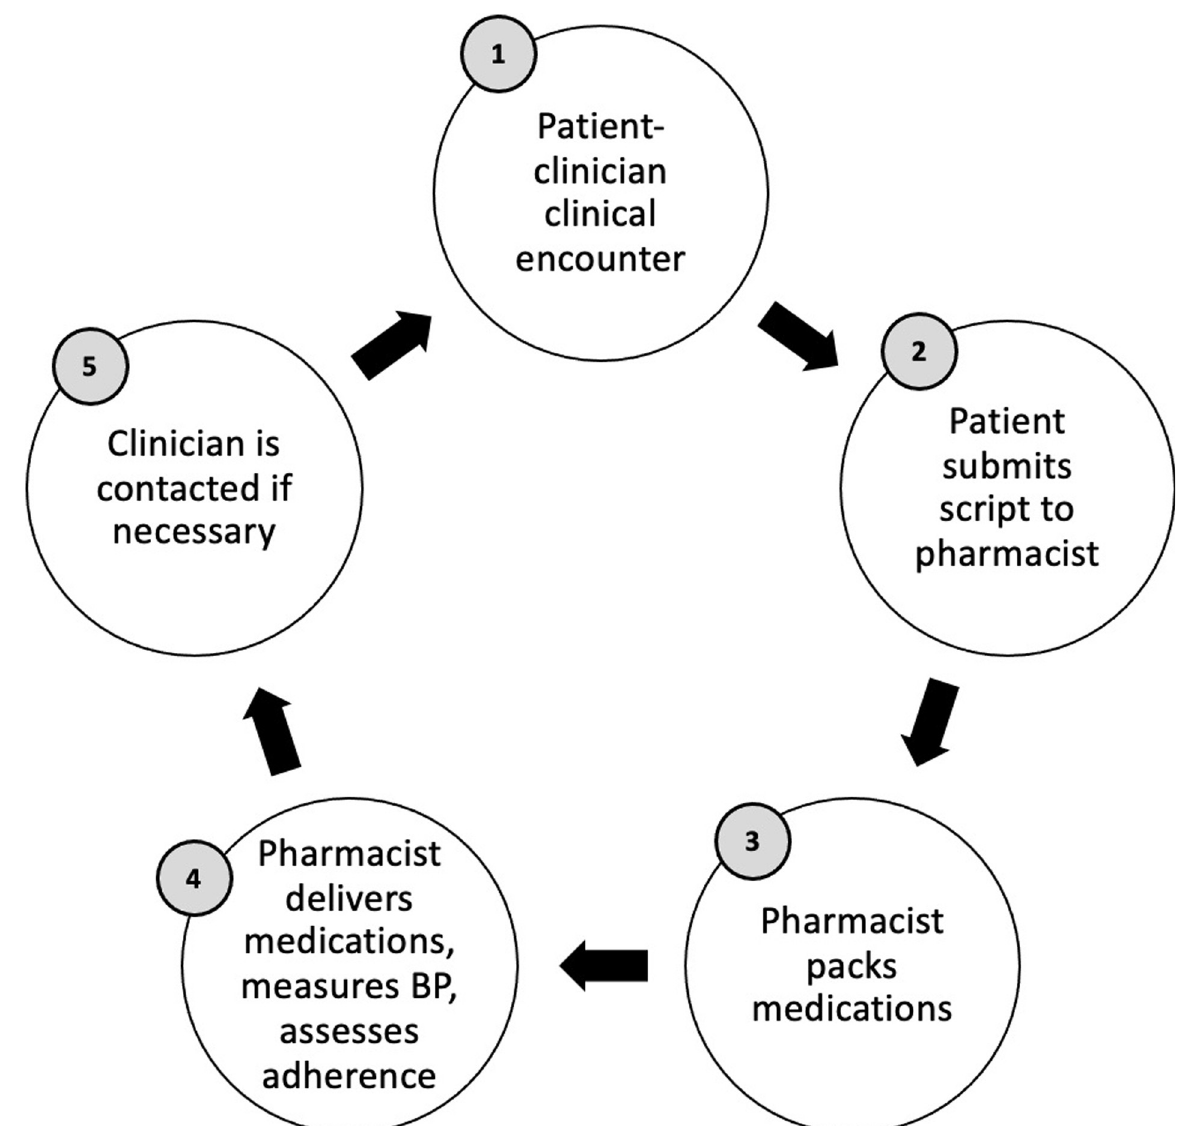
Fig 1. Summarized depiction of the medication delivery process. communicated, confirmed, and verified by the pharmacist. Upon these requests, the pharmacist then pre-packed medications in opaque brown bags to conceal the specific types of medicines inside the bags and ensure patient confidentiality. The date, time, and location of delivery were also agreed upon by the patient and the pharmacist who was conducting the delivery at the time the request for medication delivery was made. The pharmacist would travel to medication drop-off points such as a patient’s individual home, a local church, a local dispensary, or any other agreed upon public locations that the patient could easily access by foot. The travel dis- tance from the pharmacy to the patient’s drop-off point ranged between 5–35 km, and the motorcycle travel time ranged between 15–50 min. While baseline BP was measured during routine clinical appointments with the clinician, other BP checks as well as self-reported